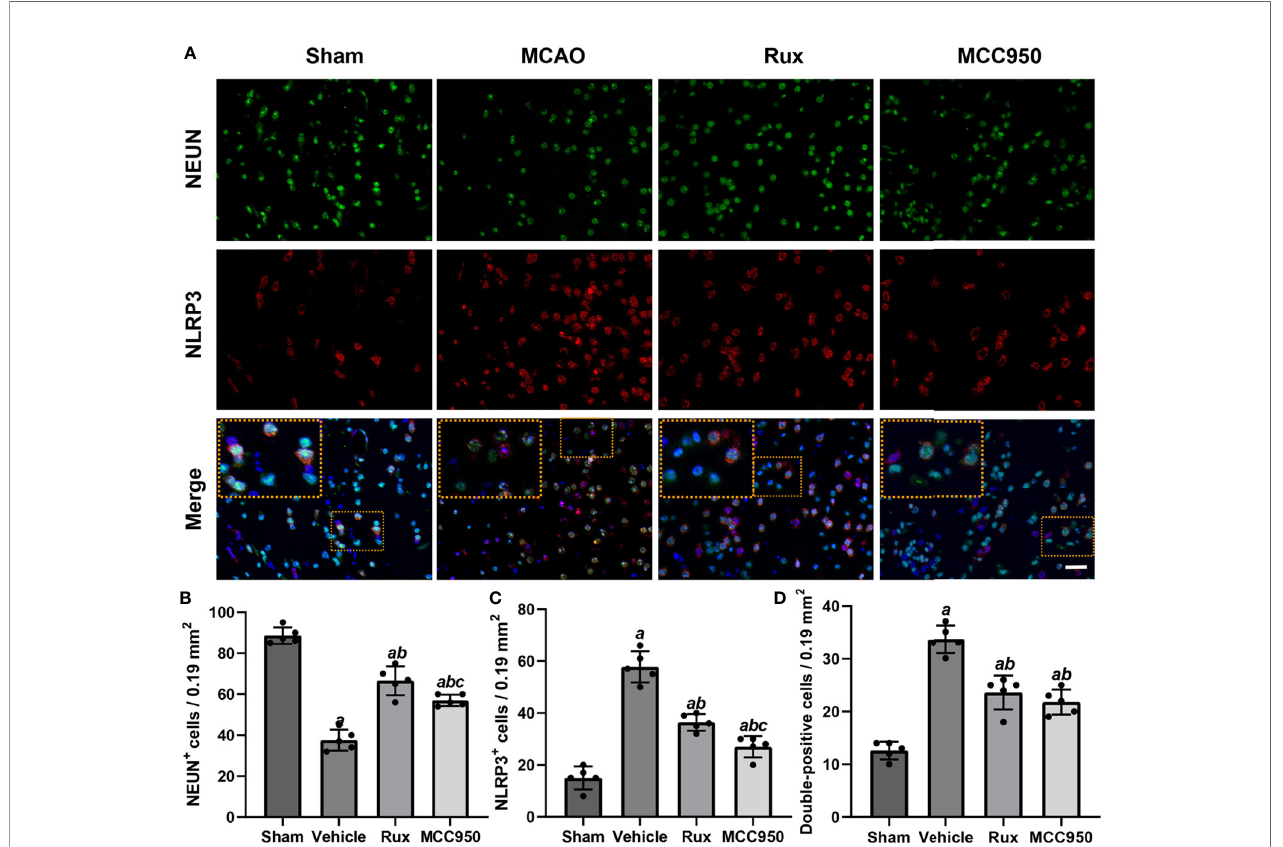
FIGURE 3 | Rux treatment reduced the number of NLRP3 + cells and increased the number of NeuN + cells in the ischemic penumbra 3 days after MCAO. (A) Representative immunostaining of NLRP3 and NeuN in the penumbra zone in sham-, vehicle-, Rux- and MCC950-treated mice. (B, C) Statistical analysis of NLRP3 + and CD68 + cells. (D) Quanti fi cation results of double-positive cells in the peri-ischemic region. Means ± SD. n = 5. a P < 0.01 versus sham; b P < 0.01 versus vehicle; c P < 0.05 versus Rux. Scale bar: 50